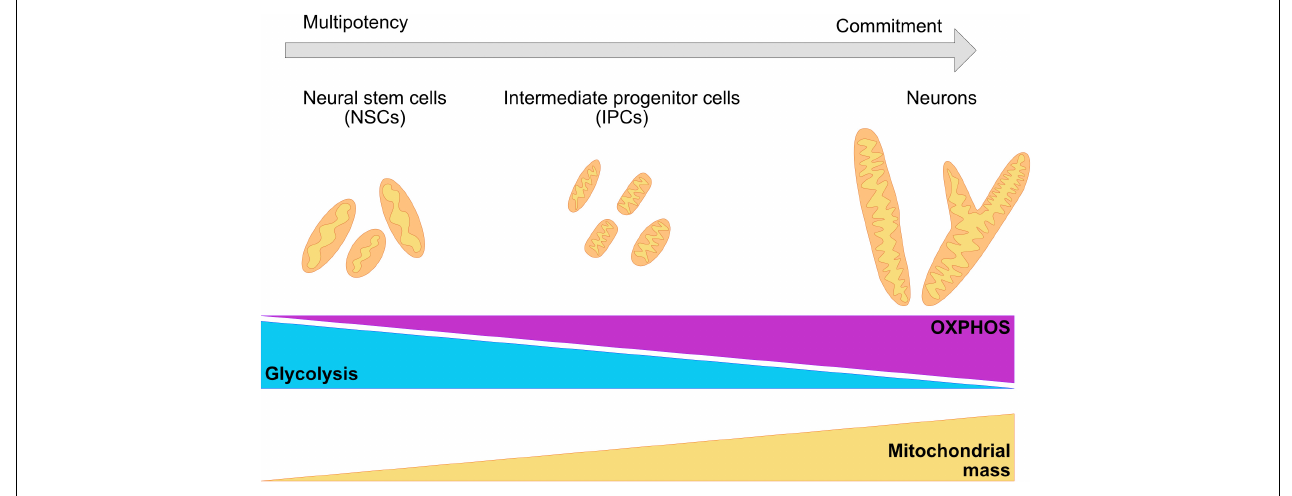
FIGURE 3 | Changes in the morphology of the mitochondrial network are required for the commitment of neuronal fate. During neurogenesis, the mitochondrial network undergoes crucial remodeling to adapt to the bioenergetic necessities of the cell, as well as the requirements of the environment. NSC have been shown to present a mildly elongated mitochondrial network with a mix of globular and tubular mitochondrion. IPCs cells are characterized for fragmented, thin, and elongated networks. Committed neurons have a wider and elongated mitochondrial network. A metabolic switch from glycolysis to OXPHOS is necessary for the acquisition of the neuronal fate and it is associated with remodeling of the mitochondrial cristae, as well as with the increase of the number of mitochondria and mitochondrial